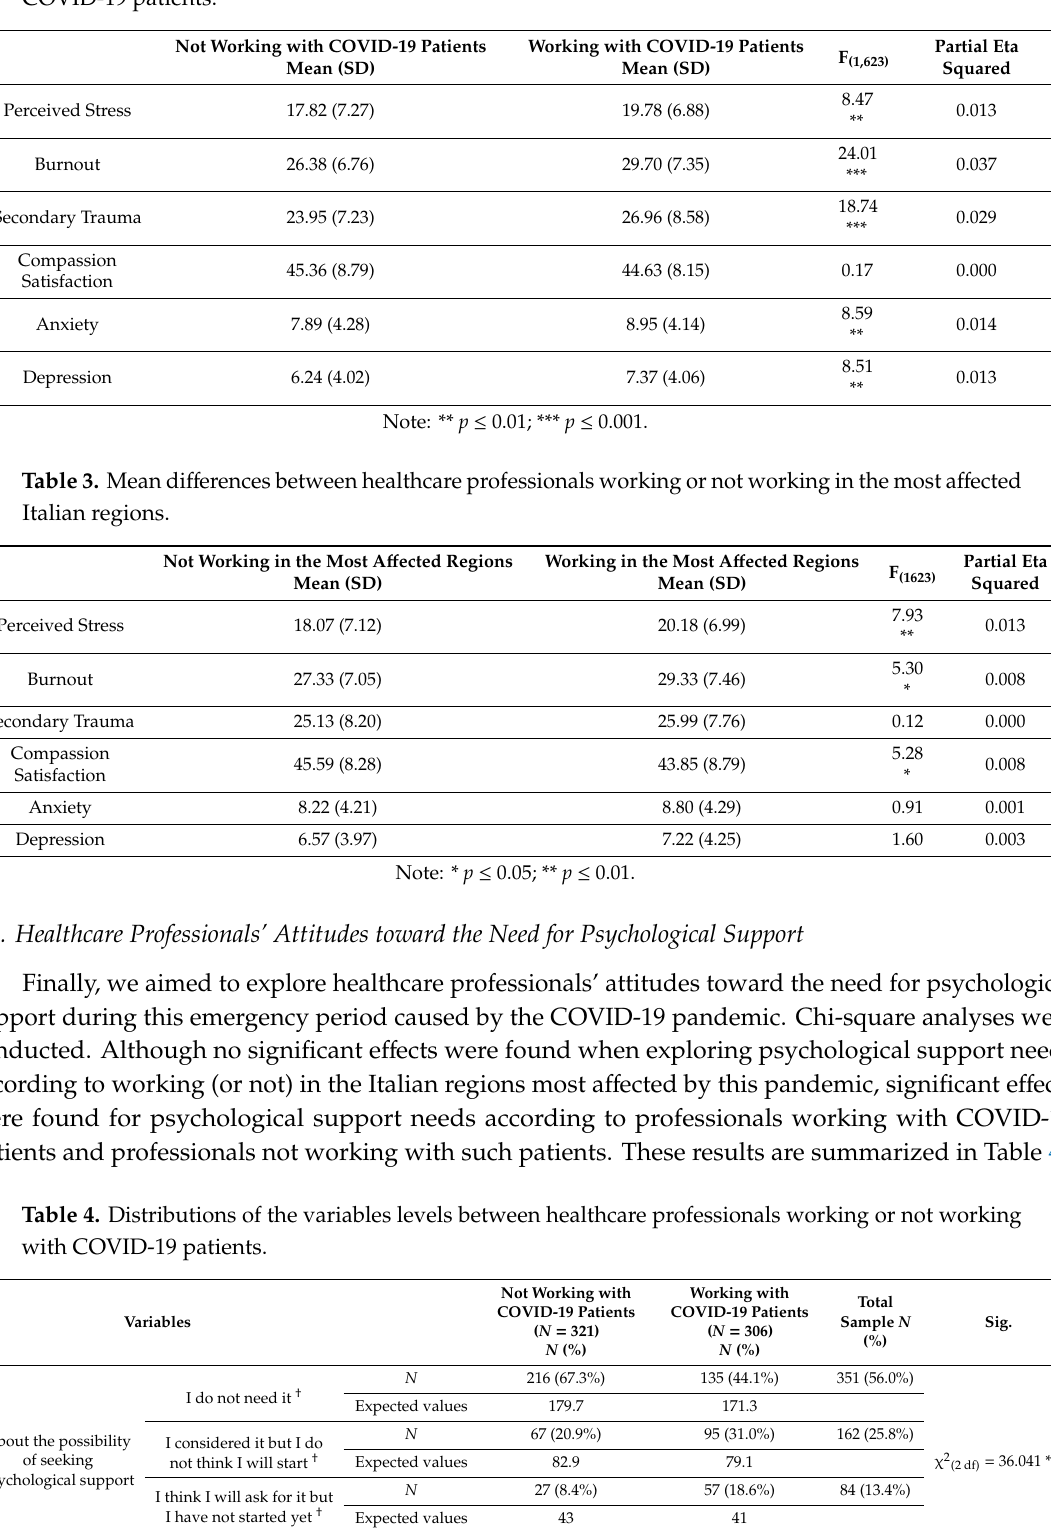
Table 2. Mean di ff erences between healthcare professionals working or not working with COVID-19 patients.